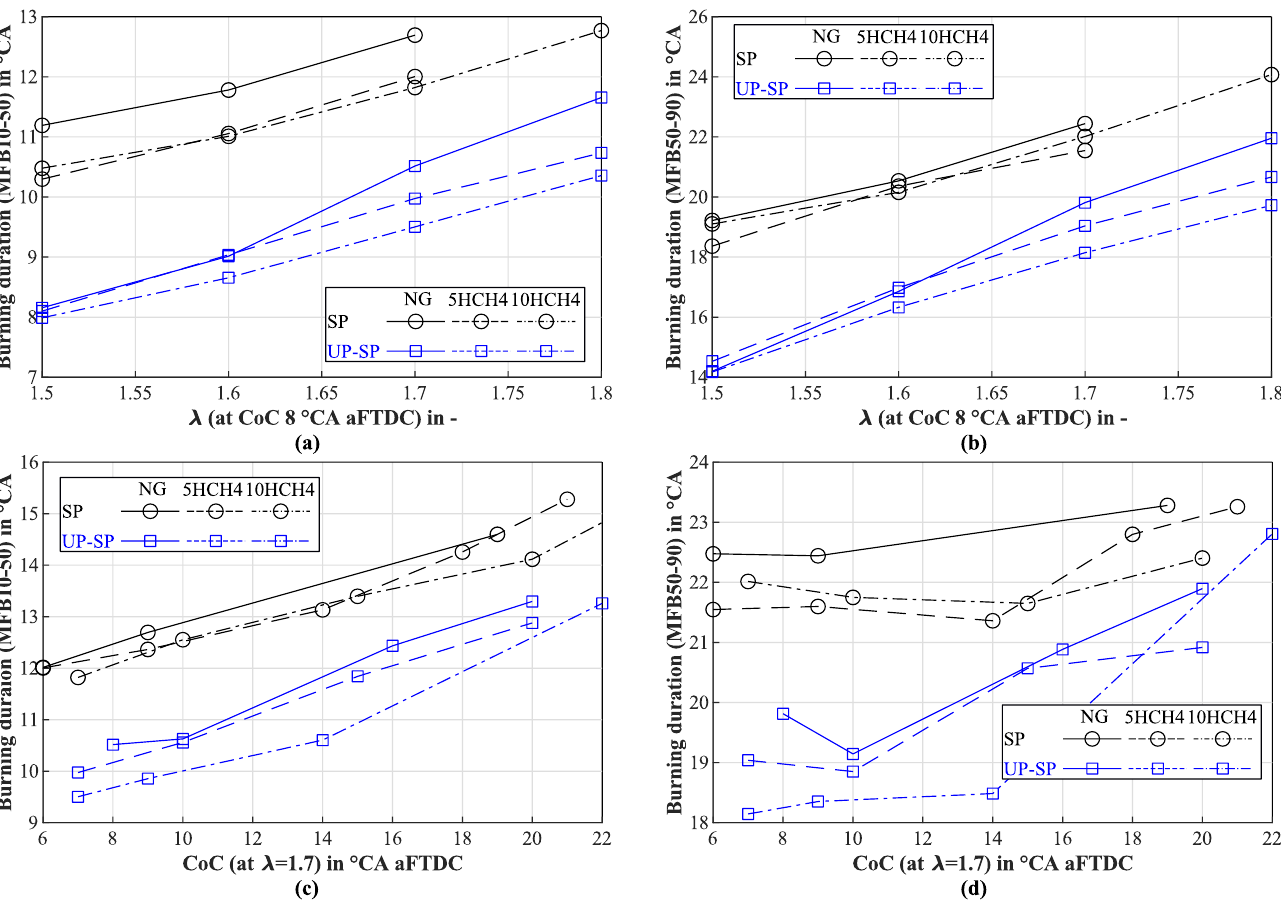
Figure 3. ( a ) Burning duration from 10 – 50 MFB at constant CoC = 8 °CA aFTDC ; ( b ) Burning duration from 50 – 90 MFB at constant CoC = 8 °CA aFTDC ; ( c ) Burning duration from 10 – 50 MFB at constant λ = 1.7; ( d ) Burning duration from 50 –90 MFB at constant λ = 1.7 .